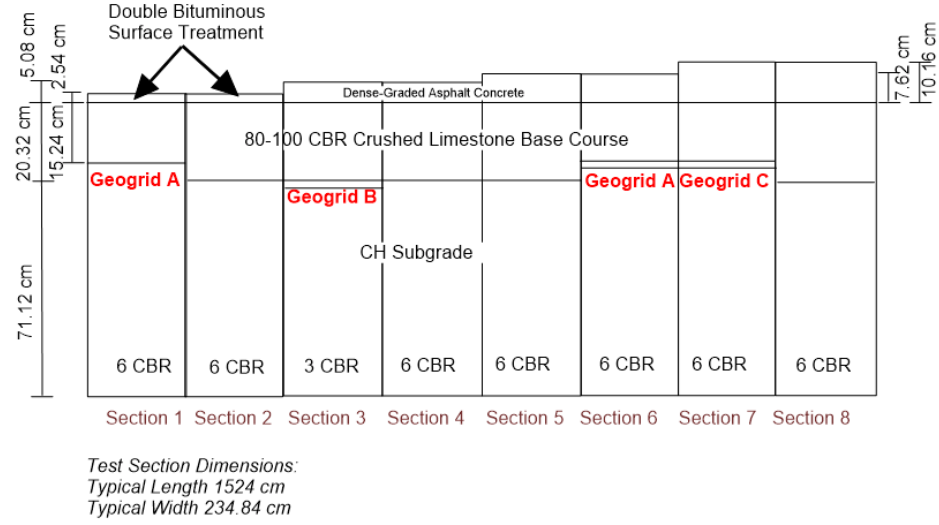
Figure 28. ERDC test sections build-up (adapted from [148]).